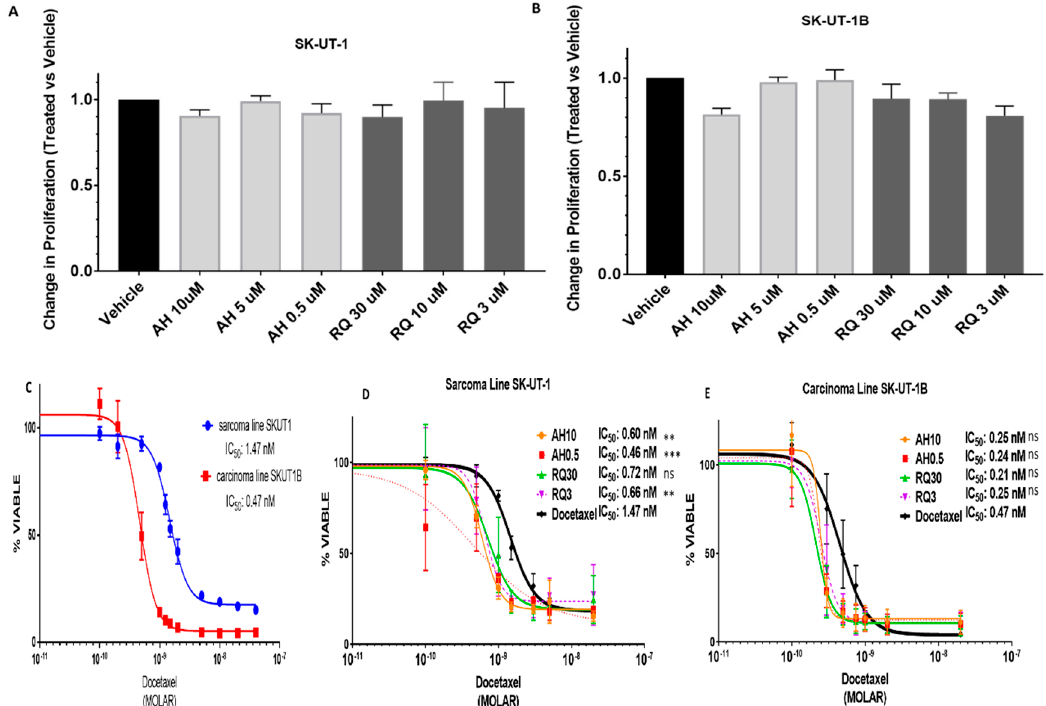
Figure 6. Effect of EP4 antagonists AH23848 and RQ15986 on SK-UT-1 and SK-UT-1B on proliferation and response to docetaxel ( A , B ) There was a modest effect on cell proliferation on SK-UT-1 (7% decrease, n.s.) and SK-UT-1B (20% decrease, n.s.). Data are normalized to the vehicle control.